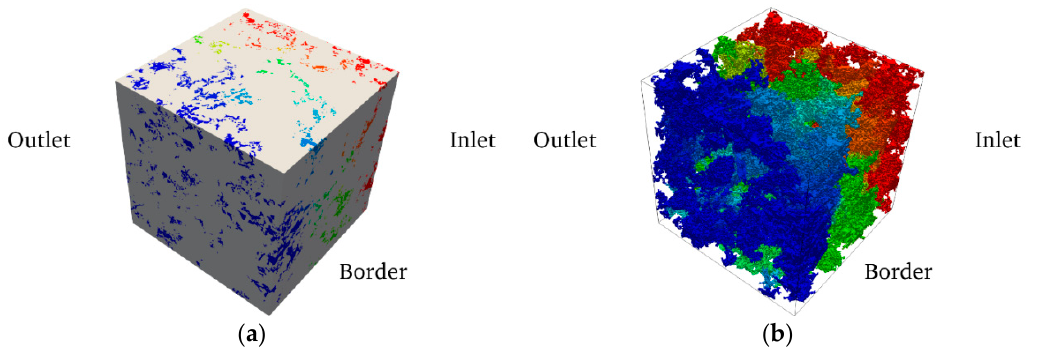
Figure 5. Computation domain of reconstructed structure. ( a ) Whole domain including gray solid part and color pore part is presented; ( b ) Only pore part structure is presented. The color reflects the pressure distribution.